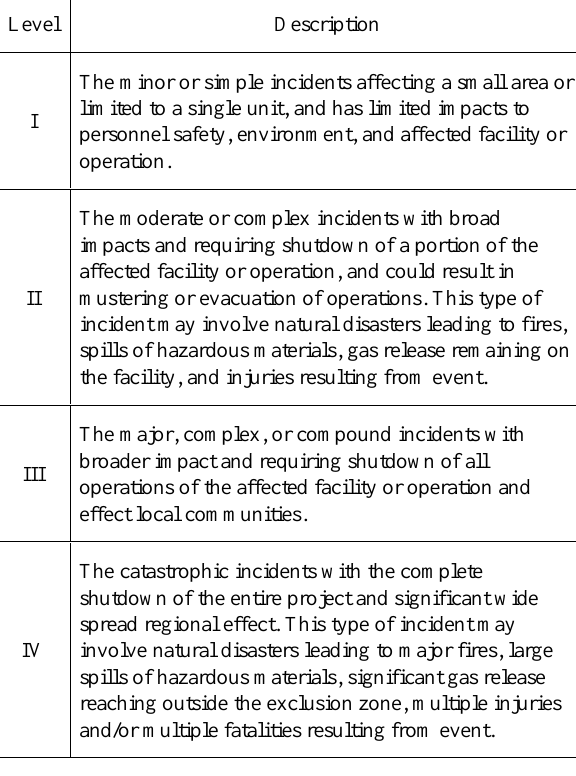
Table 1. Incident response levels of emergency response